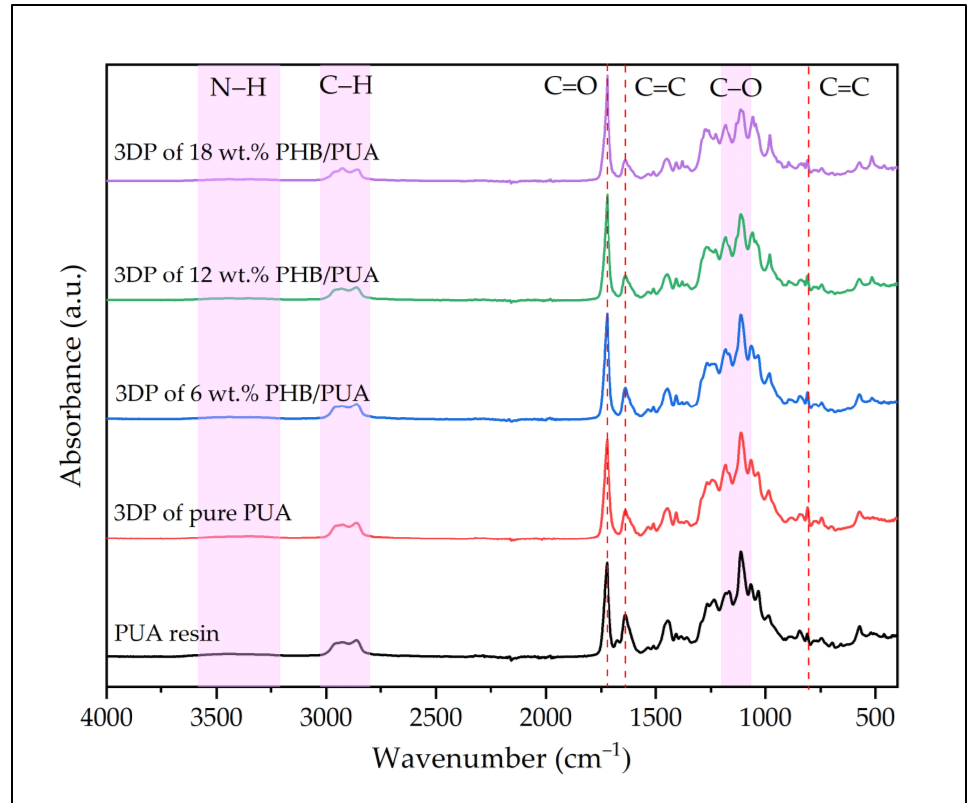
Figure 5. Infrared spectrum of PUA resin and 3D-printed PUA and PHB/PUA blend compositions.